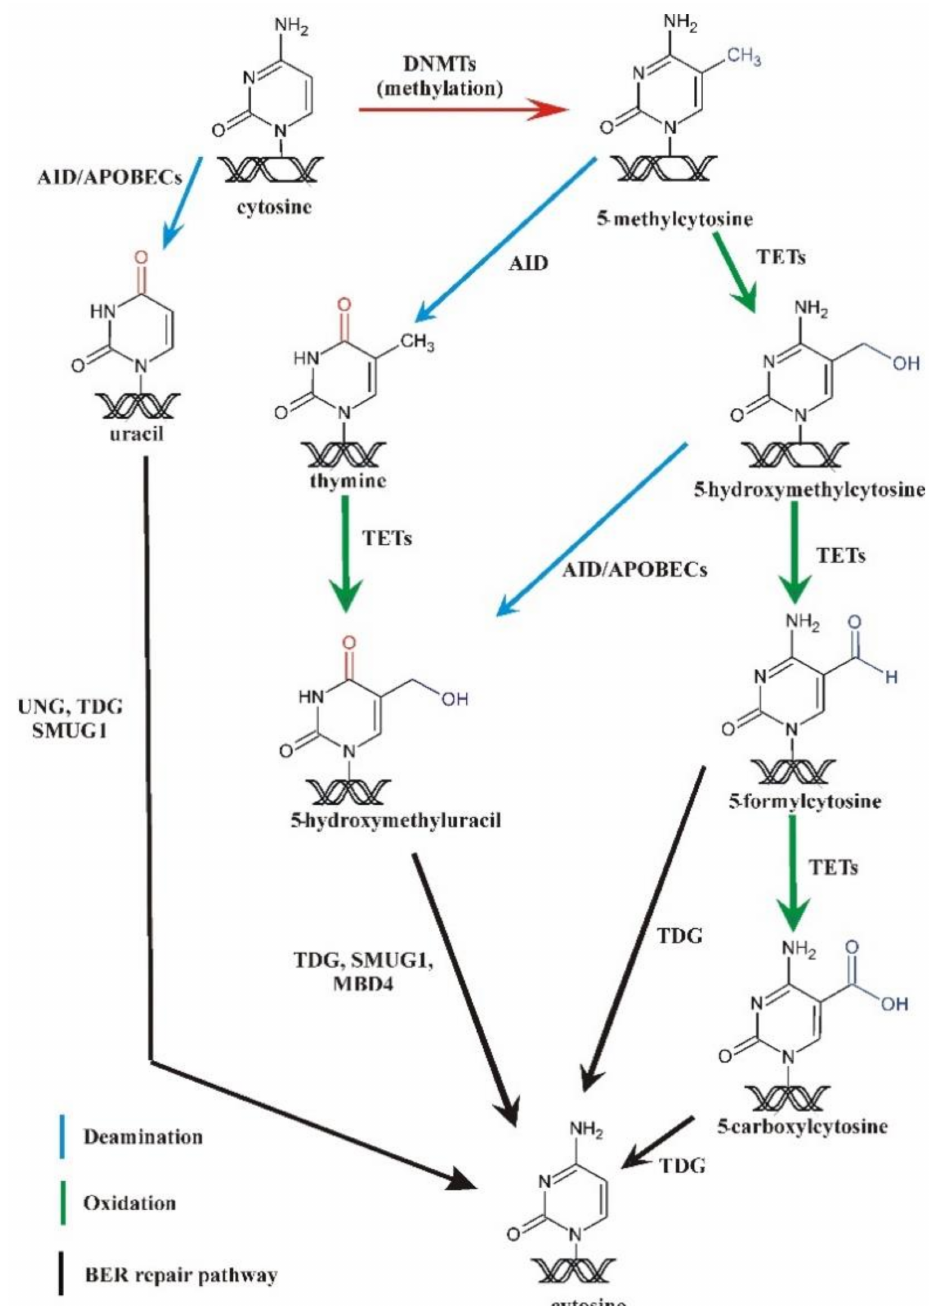
Figure 3. Cytosine methylation and active demethylation pathway. 5mC is formed in DNA methyl- transferase (DNMT)-catalyzed reaction. The mechanisms of active 5mC demethylation include involvement of ten-eleven translocation (TET) proteins in oxidation of